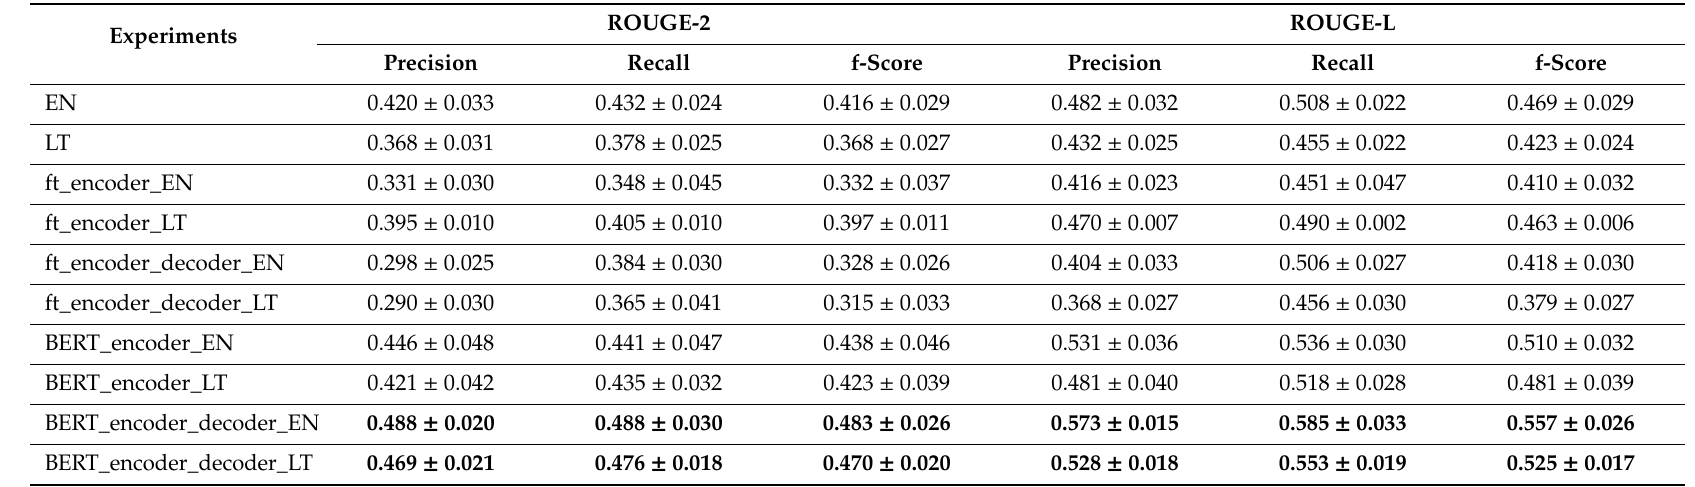
Table 7. Averaged ROUGE-2 and ROUGE-L precision / recall / f-score values with confidence intervals using the BiLSTM encoder and LSTM decoder model with di ff erent vectorization types on the dataset with separated punctuation. The best values in the column for EN and LT are in